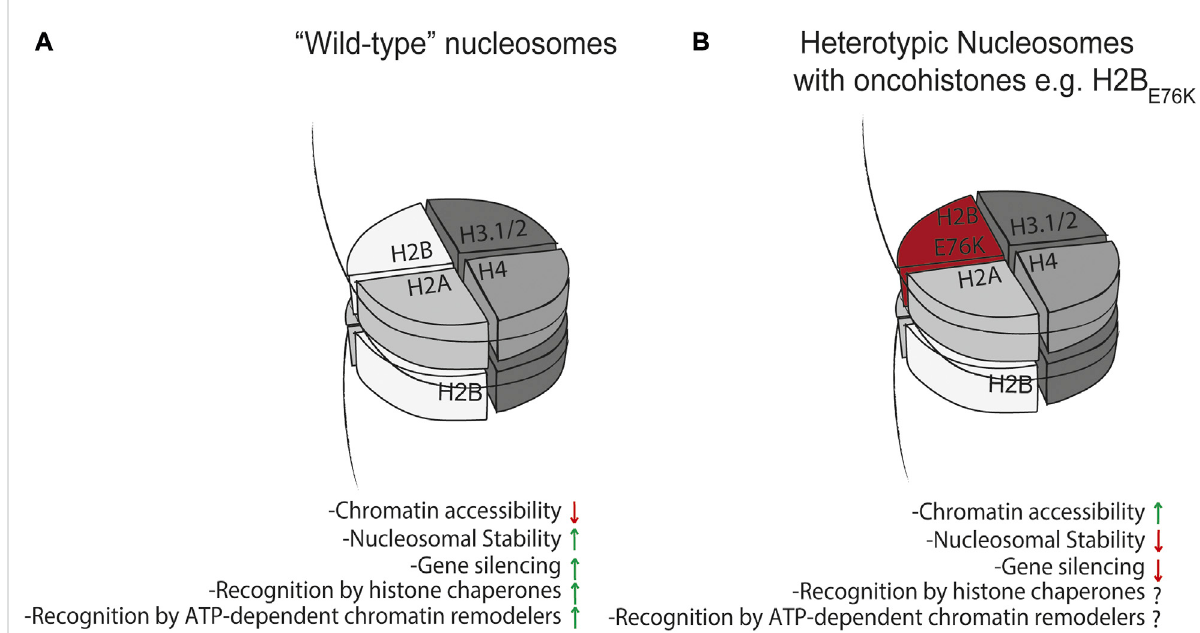
FIGURE 3 Effect of mutant histones on nucleosome dynamics. (A) “ Wild-type ” nucleosomes can minimize chromatin accessibility, mediate gene silencing, and are recognized as substrates for histone chaperones and ATP-dependent chromatin remodelers. This is in contrast to heterotypic nucleosomes (B) containing mutant histones whichhave been shown to impair nucleosome-mediated gene silencing (Arimura et al., 2018; Bennett et al., 2019; Nacev et al., 2019), and these and other mutant histones may have altered or impaired interactions with the histone chaperone network and ATP-dependent chromatin remodelers. This may in turn affect nucleosome stability and turnover to drive